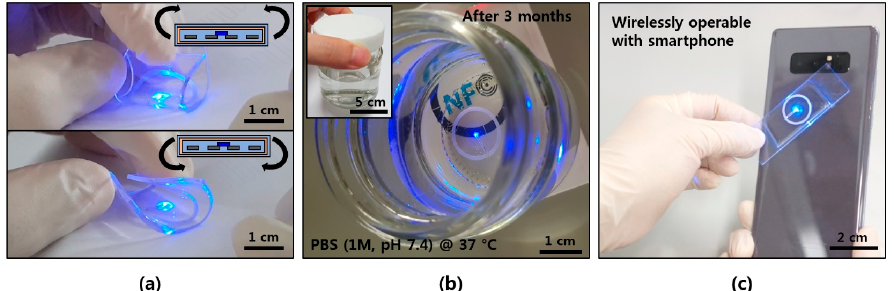
Figure 5. Photographs of wirelessly operated optoelectronic devices. ( a ) In-folded (top) and out-folded (bottom) devices with PDMS / Parylene C / PDMS protection layers during wireless operation; ( b ) wireless operation of device after three months immersed in PBS; ( c ) wireless operation of device using NFC of smartphone.